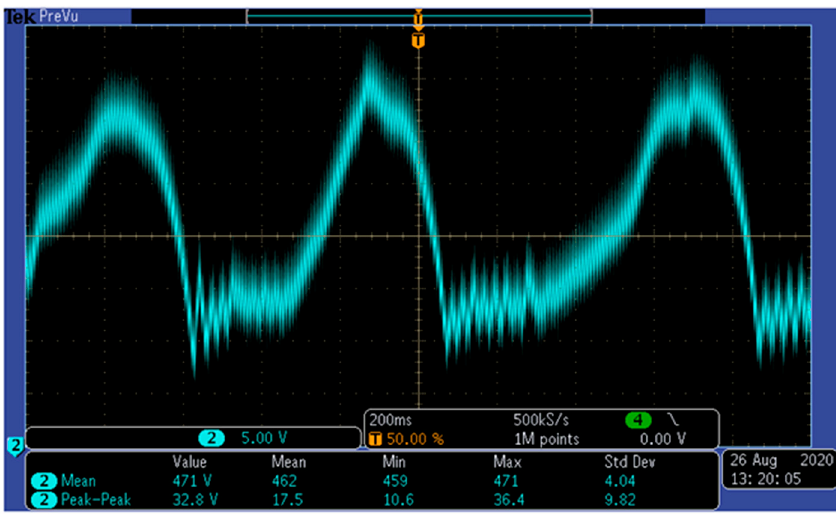
Figure 7. Oscilloscope trace of bus voltage.